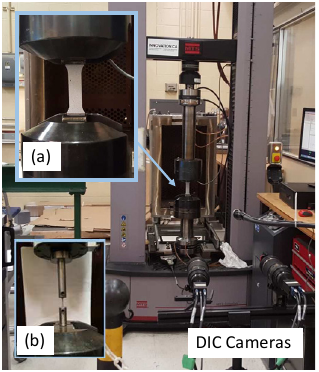
Fig. 2. Quasi-static experimental setup used for the 0.001 s -1 tests, shown while testing; (a) JIS and (b) MDB specimens.